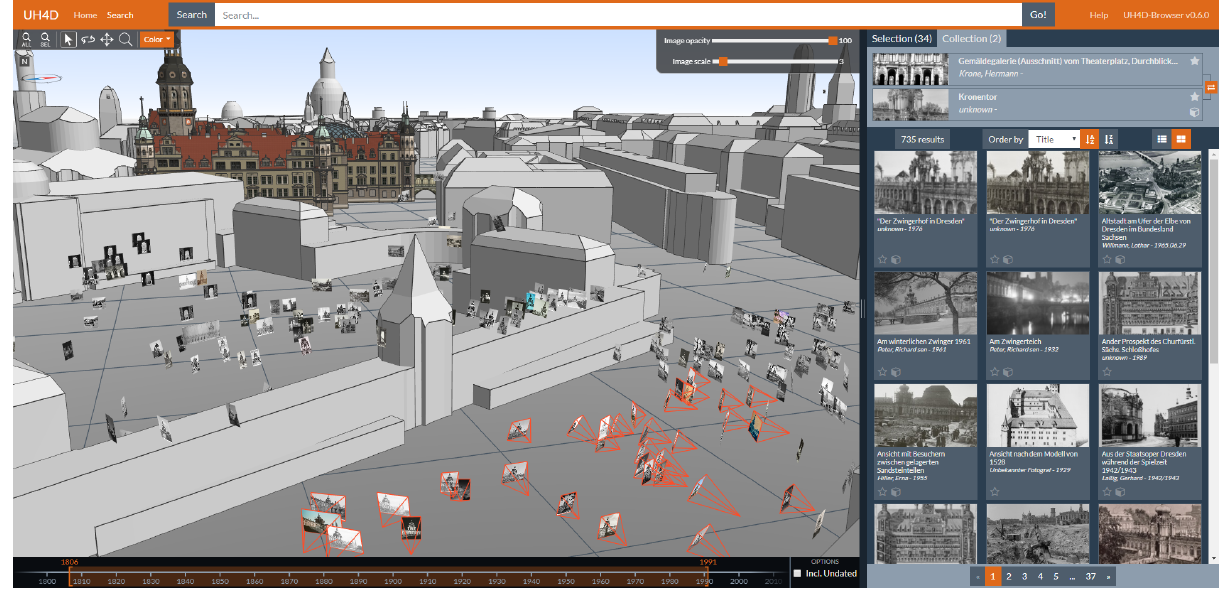
Figure 3. Prototype browser application of HistStadt4D with interactively and automatically oriented images